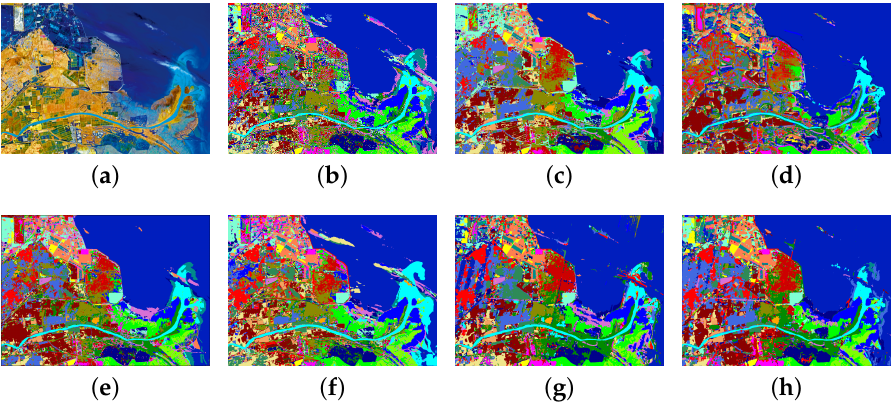
Figure 13. Classification maps predicted by different methods for YRD dataset. ( a ) Ground-truth, ( b ) 3-D CNN (90.88%), ( c ) SSRN (95.62%), ( d ) SSUN (86.35%), ( e ) S-DMM (95.48%), ( f ) CNN-AL-MRF (90.91%), ( g ) DLSN (94.22%), ( h ) ALSN